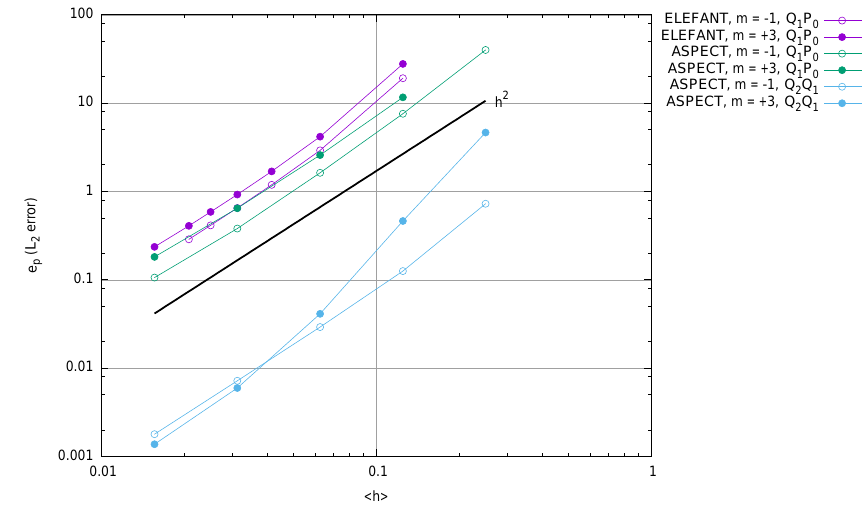
Figure 5. Pressure L 2 -norm error vs. average resolution for ELEFANT and